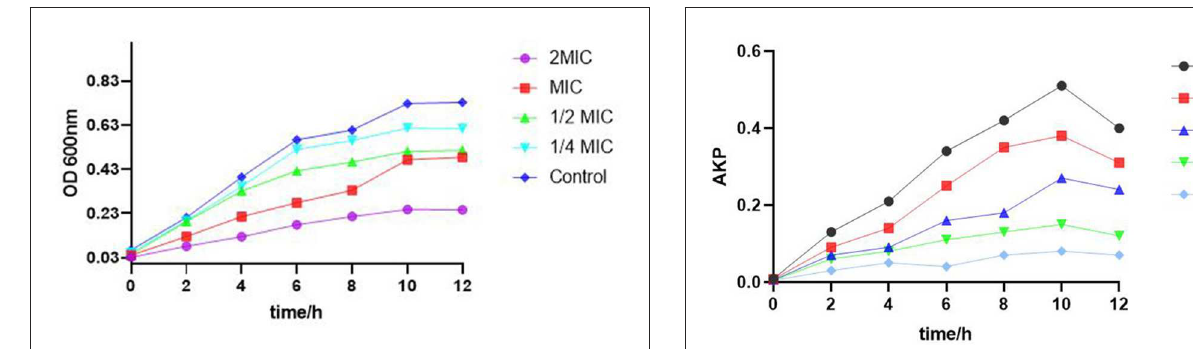
FIGURE2 Effect of SEDQS on the growth curve of Salmonella enteritidis .